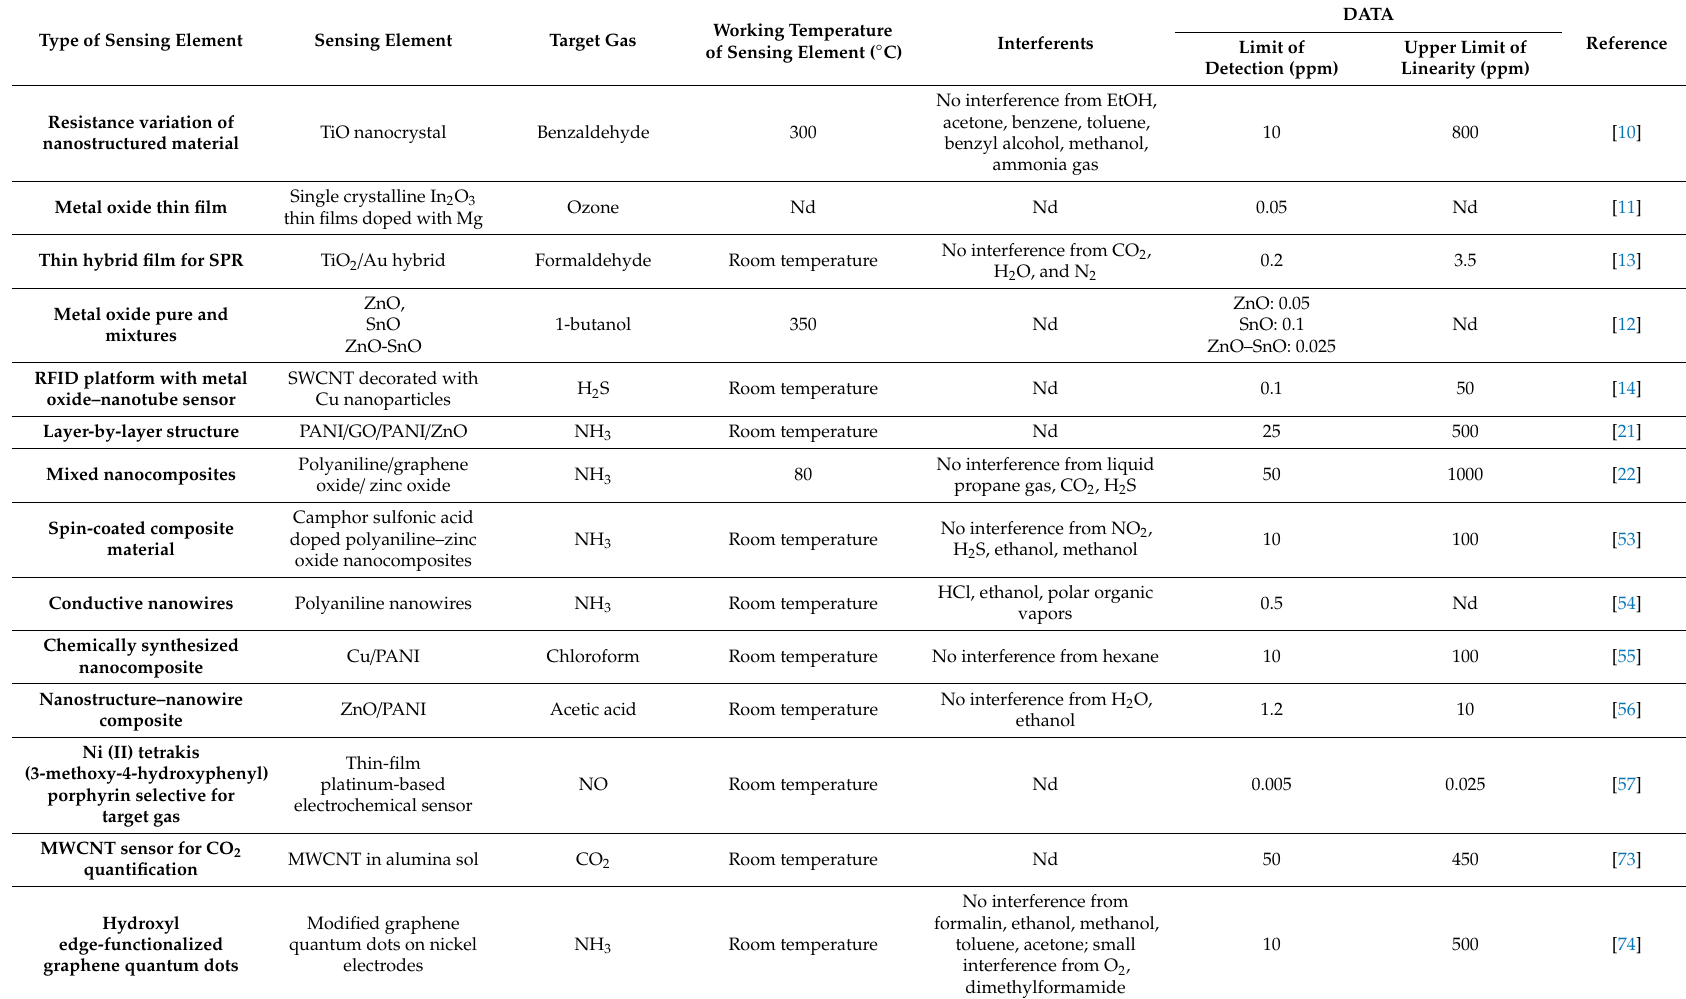
Table 5. Sensing properties of reported gas